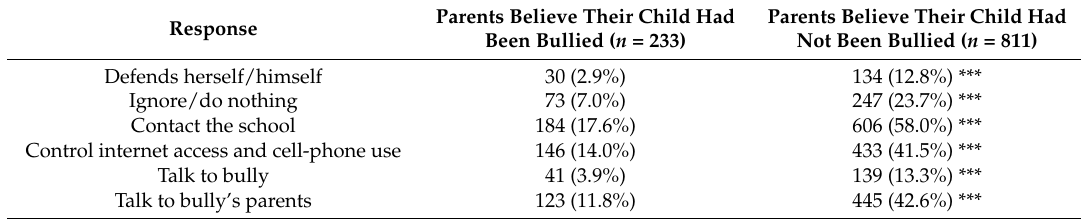
Table 4. Percentages of the parents’ responses according to the parents’ awareness of bullying involvement.